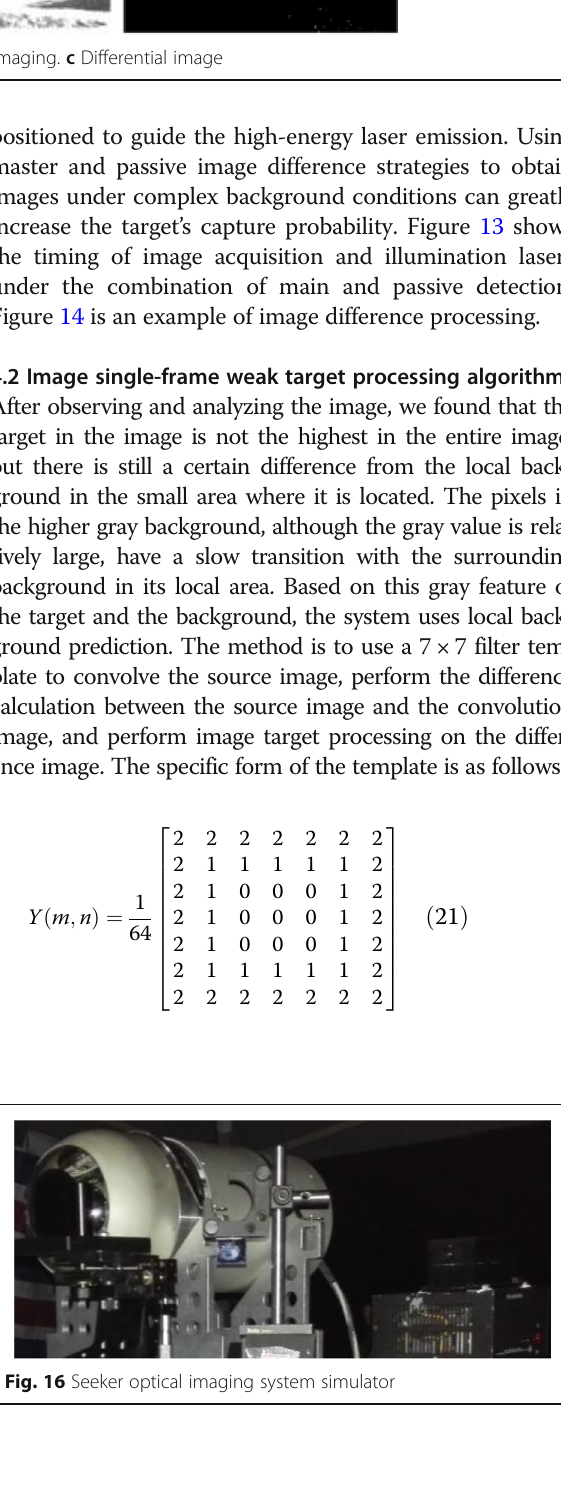
Fig. 14 Image differential processing example. a Passive imaging. b Active imaging. c Differential image